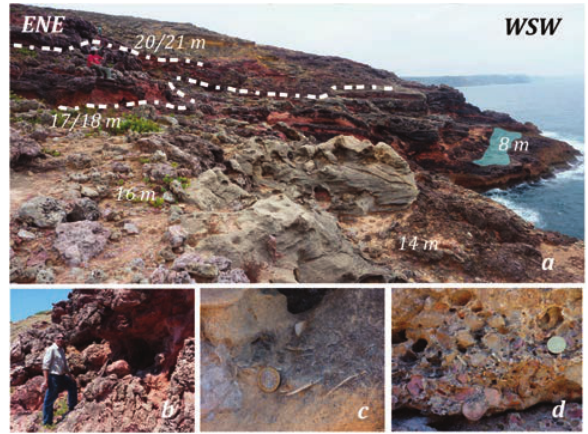
Figure 7. Panoramic view of Carrapateira, southern section Carra- pateira site: a) T2 terrace perspective ; b) notch at 20/21 m elevation c) detail of beach sand with imbricate shells; d) basal section of the sedimentary T2 sequence, laying on top of the wave-cut platform with coarser sediments at 14 m